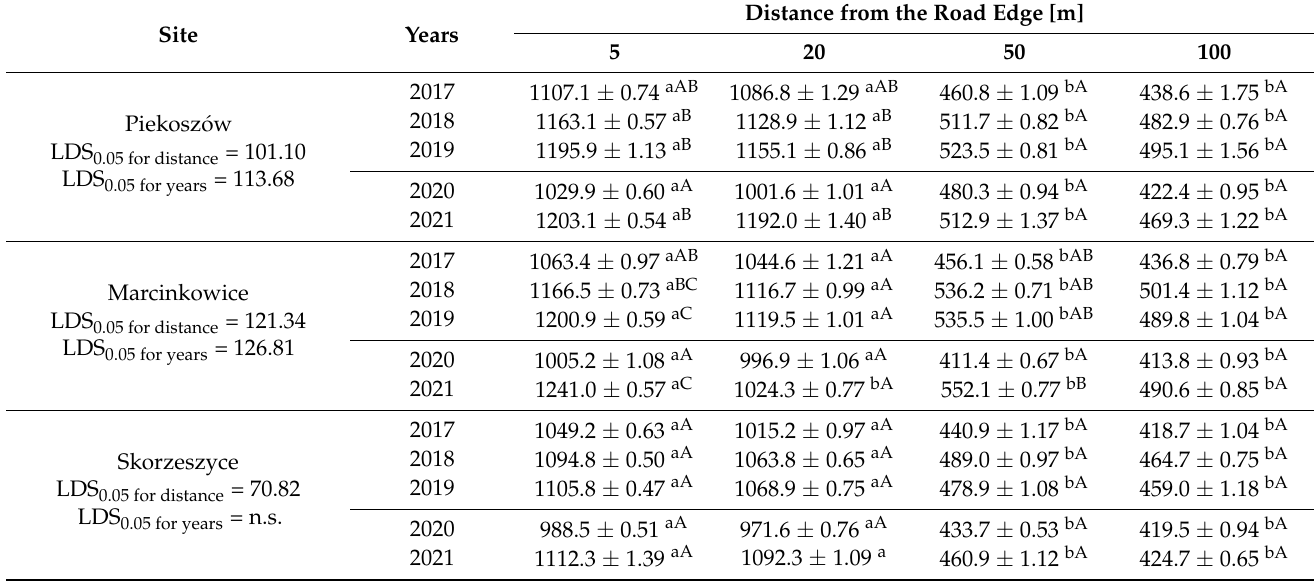
Table 8. Σ 14PAHs content ( Σ 14PAHs in ( µ gkg − 1, µ g · kg − 1) in soils before the pandemic